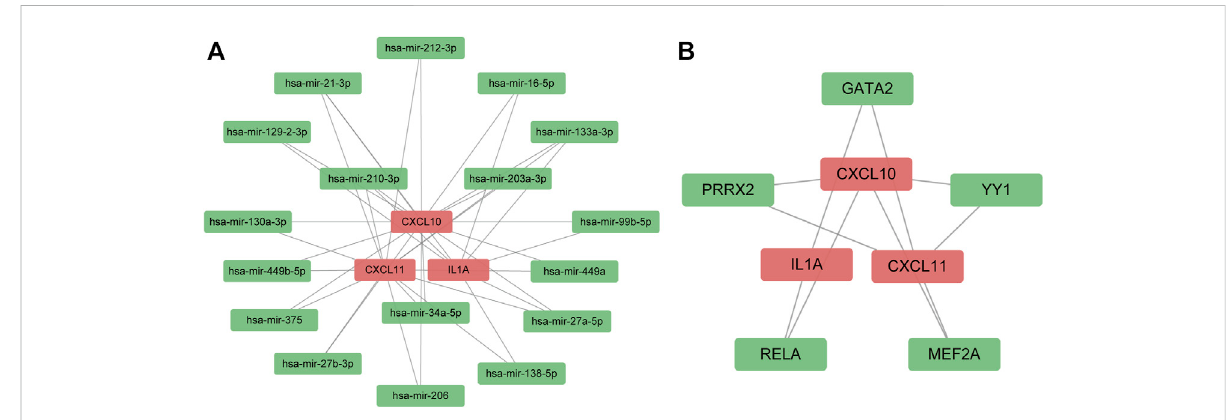
FIGURE 5 Regulatory signatures of survival-associated hub genes. (A) miRNA – gene interaction network; (B) transcription factors – gene interaction network. The red node represented survival-related hub genes. The green node indicated miRNAs and transcription